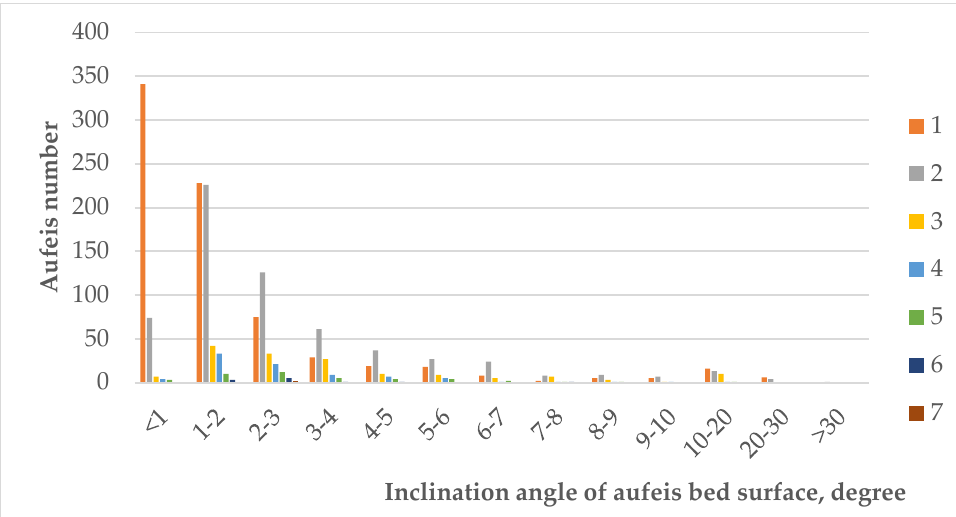
Figure 8. Plot of Aufeis number versus inclination angle for Aufeis bed surfaces in the Kunlun Mountains on northern edge of the Qinghai-Tibet Plateau, West China Mountains; 1–7-orders of river channels.